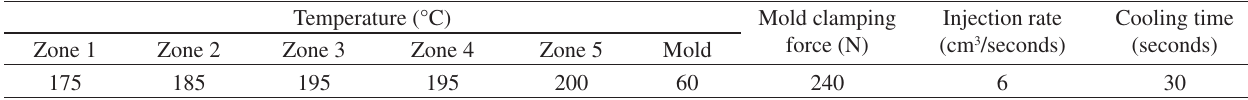
Table 2. Injection conditions of the PHB/PP